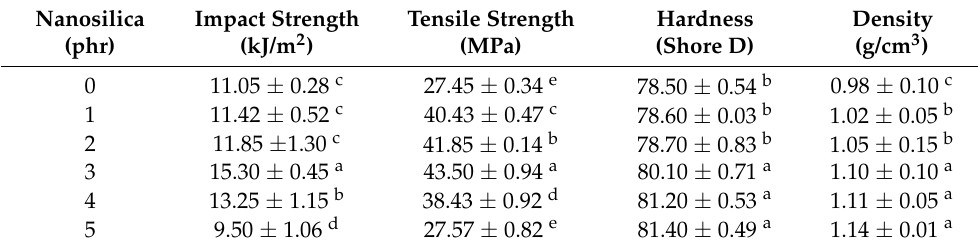
Table 2. The mechanical properties of nanocomposites.